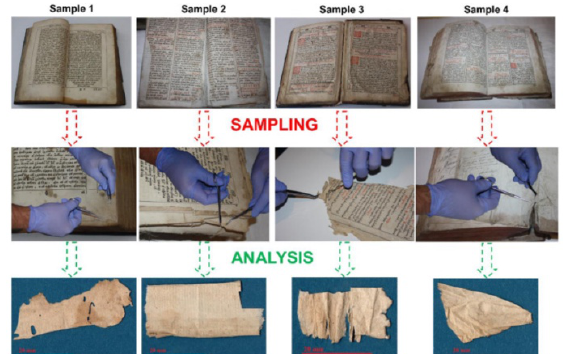
Figure 7. Recipes testing on real (top) and simulated paper artefacts